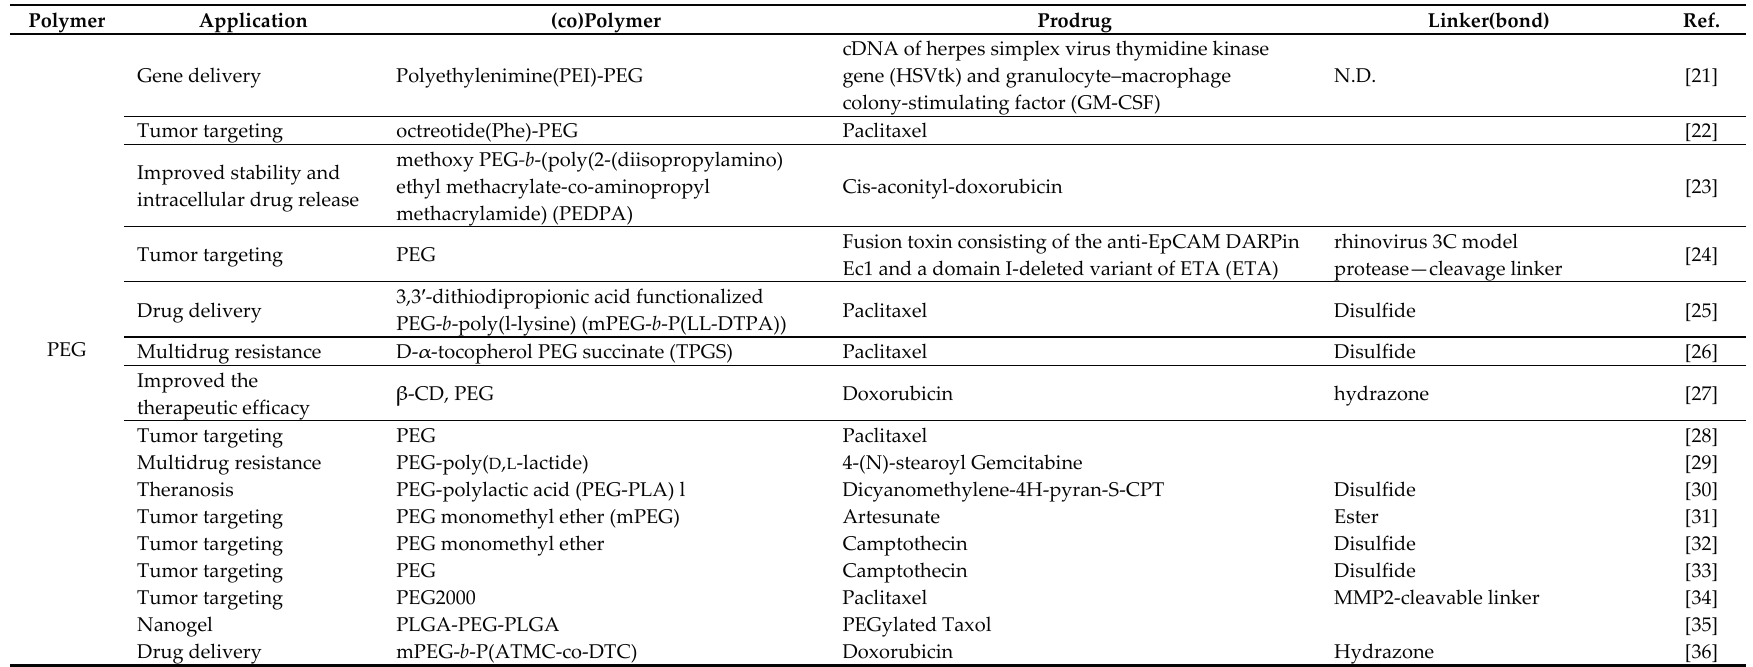
Table 1. Recent applications of synthetic polymers in prodrug